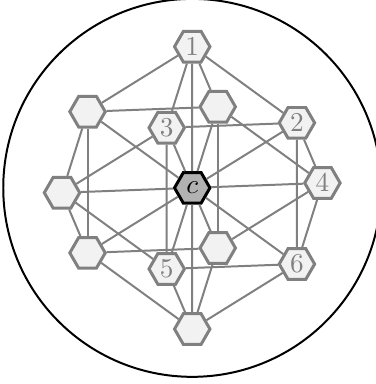
Fig. 7. Vertex labelling congruent with directions ϑ k ; opposite directions ( − ϑ k ) omitted.